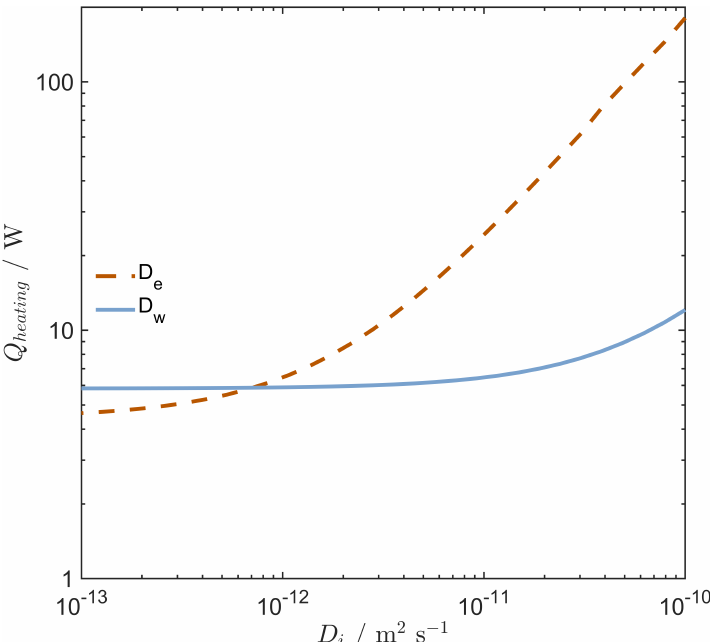
Figure 5. Contour plots of simulated ( a ) hydrogen production, F H function of the inlet molalities of the concentrate channel, m 2 , and of the dilute channel, m 1 , for the evaporation case , and m 1 > m 2 is not shown.